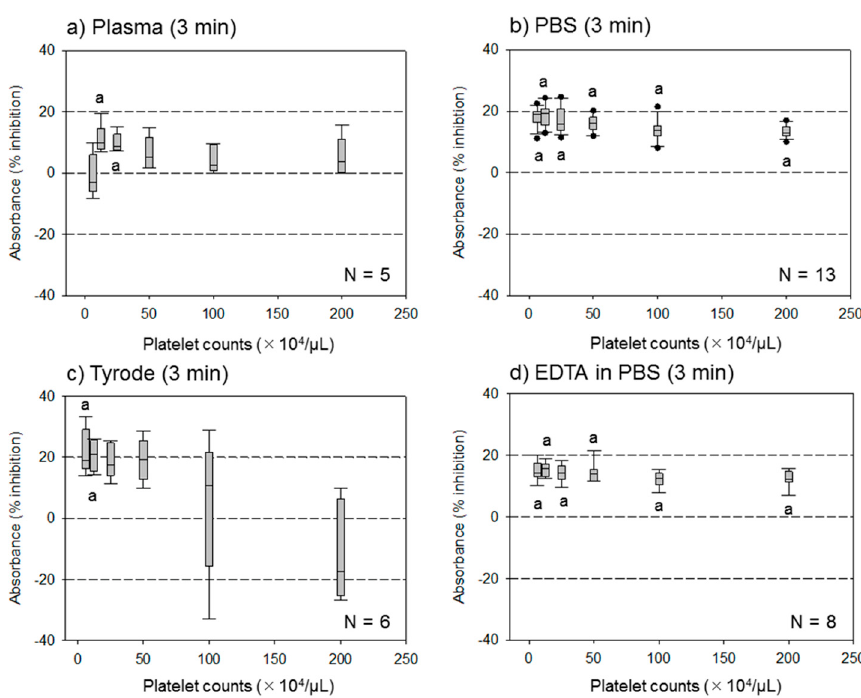
Figure 1. Effects of different assay buffer solutions on the adenosine diphosphate (ADP)-induced platelet aggregation. Platelets were suspended in ( a ) acellular plasma, ( b ) phosphate buffered saline (PBS), ( c ) Tyrode buffer solution, or ( d ) ethylenediaminetetraacetic acid (EDTA)-containing PBS at the indicated densities and stimulated with 5 μ M ADP for 3 min at 22–24 °C. a p < 0.05 compared with individual corresponding controls at 0 min.